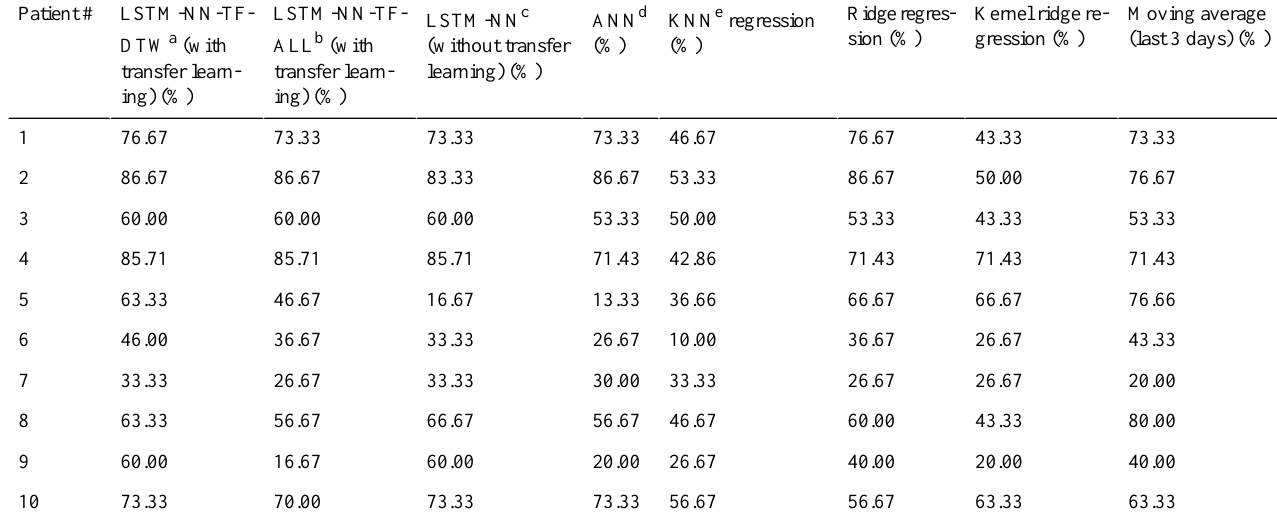
Table 3. Prediction accuracy of the proposed deep learning models along with other comparing methods based on the ±10% range of the actual glucose level